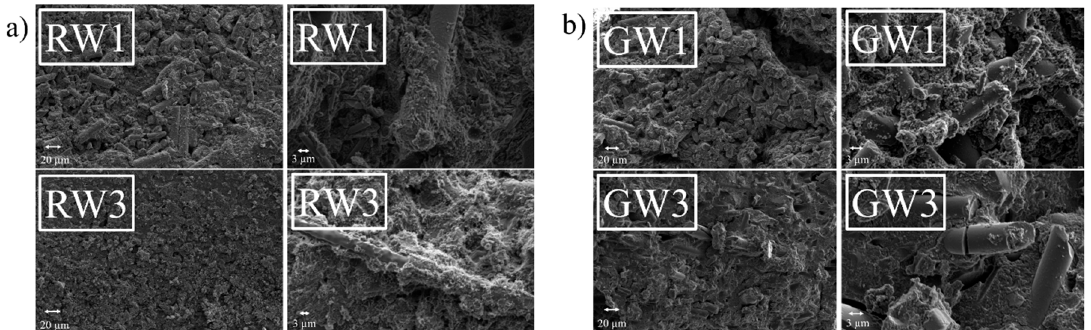
Figure 5. Secondary electron image of the fracture surface of ( a ) the rock wool (RW); and ( b ) glass wool (GW) geopolymer samples. On the left side of the images is a general look of the surface and on the right side of the images is a more detailed image showing the composite-type structure.